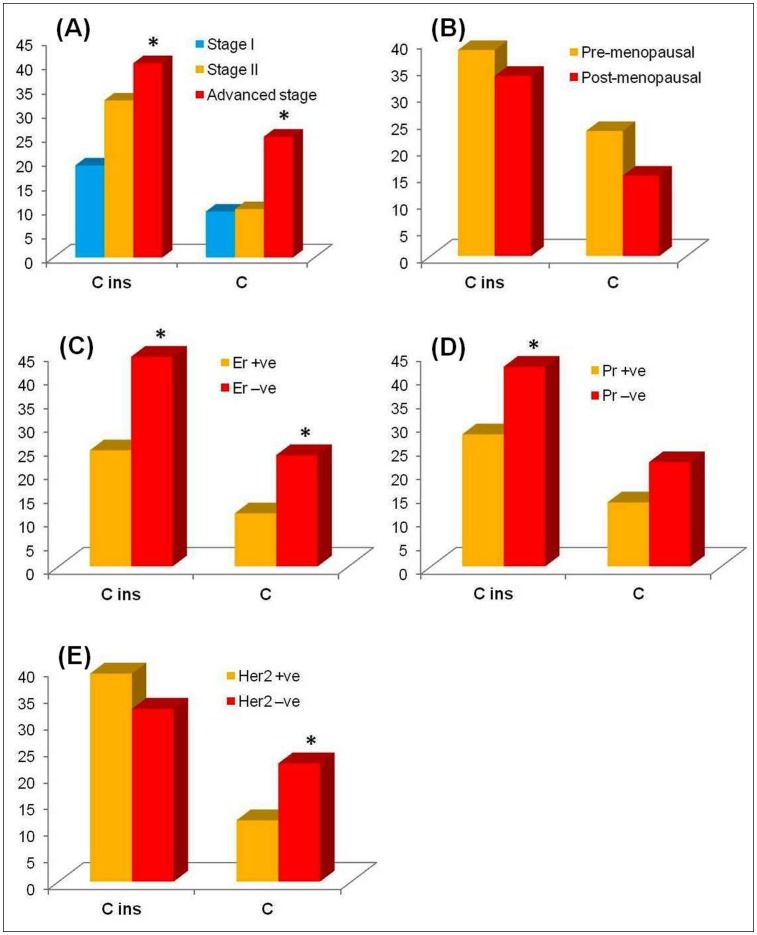
Graphical representation of minor allele frequencies of significant D-loop SNPs in breast cancer patients with different clinical parameters:(A) breast cancer stage; (B) menopausal status; (C) estrogen receptor status; (D) progesterone receptor status; (E) human epidermal growth factor receptor 2 status. Asterisk (*) indicates the significant difference (P<0.05, as determined by the Student’s t-test) between patient groups with different clinical parameters. Percentage values were used for statistical analysis.